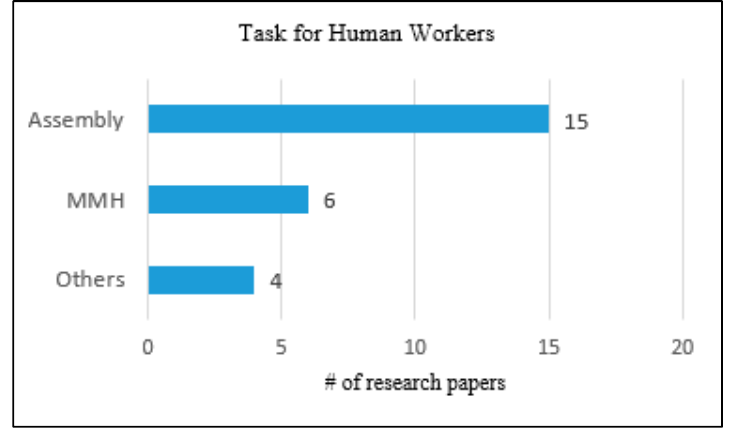
Figure 7. Tasks for human workers of existing applications.